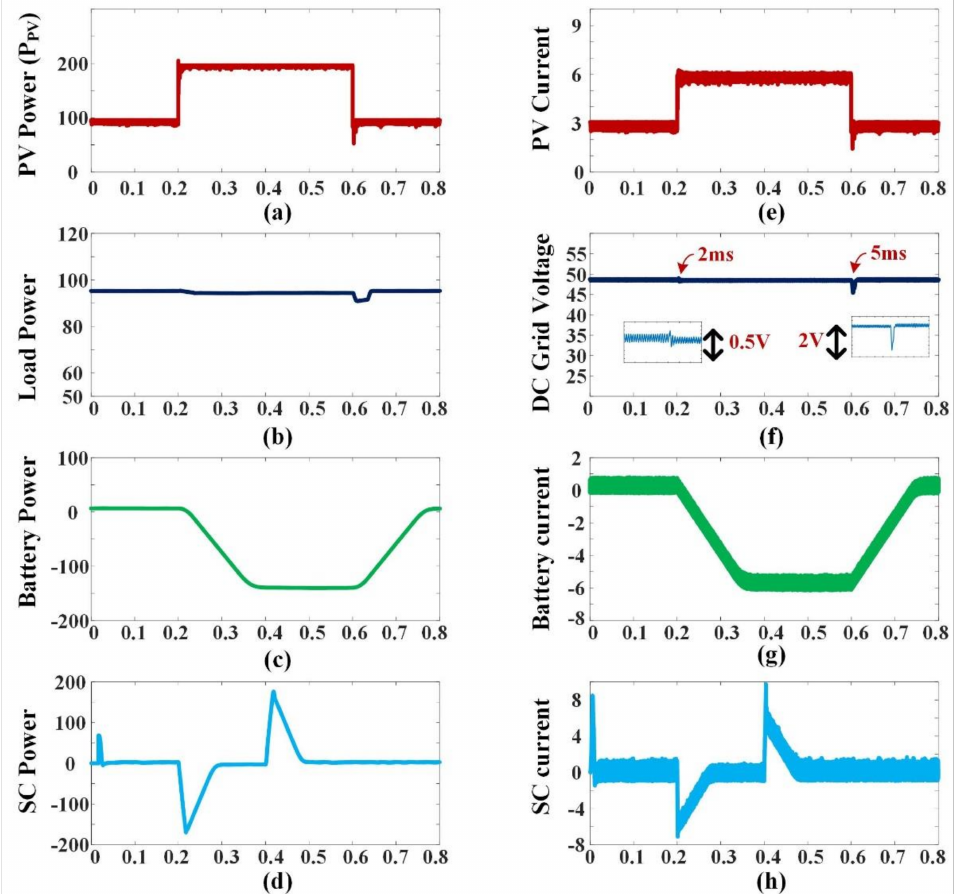
Figure 14. Simulation findings for MPC control of a step change in PV generation ( a ) PV power generation, ( b ) load power demand, ( c ) battery storage power, ( d ) SC storage power, ( e ) PV current generation, ( f ) DC microgrid voltage, ( g ) battery storage current and ( h ) SC storage